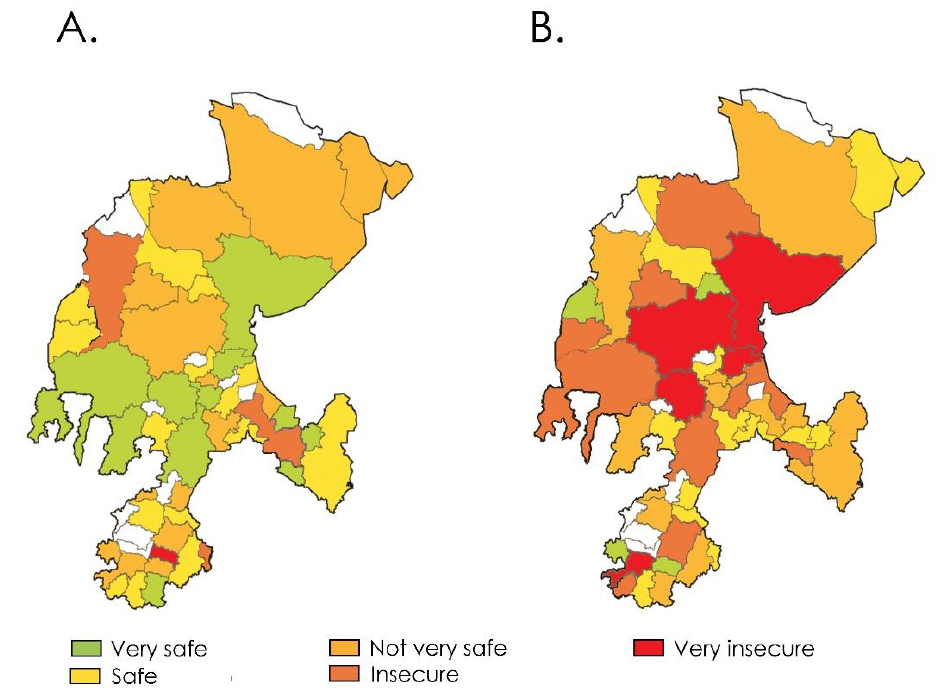
Figure 6. Level of security perceived by SSMIs in medical units and municipalities of the state of Zacatecas. The Figure shows a colorimetric representation of the municipalities according to the perception of safety that the SSMIs had on the medical units ( A ) and on the municipalities where these units were located ( B ). See the guide map (Supplementary Figure S1) for the identification of the municipalities.